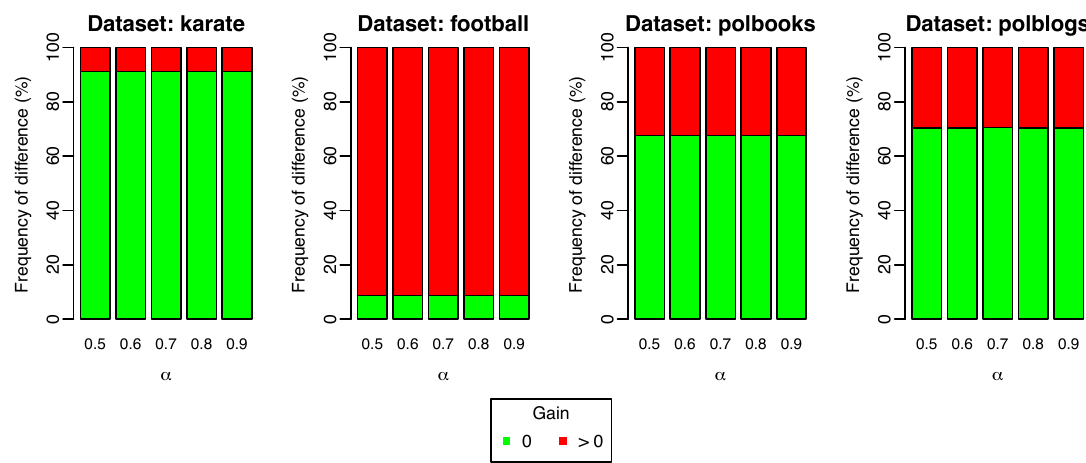
Figure 10. Comparison between the bound calculated considering the whole graph and the bound calculated considering only the first and second graph of the starting node, for both cases only one iteration of improvements has been